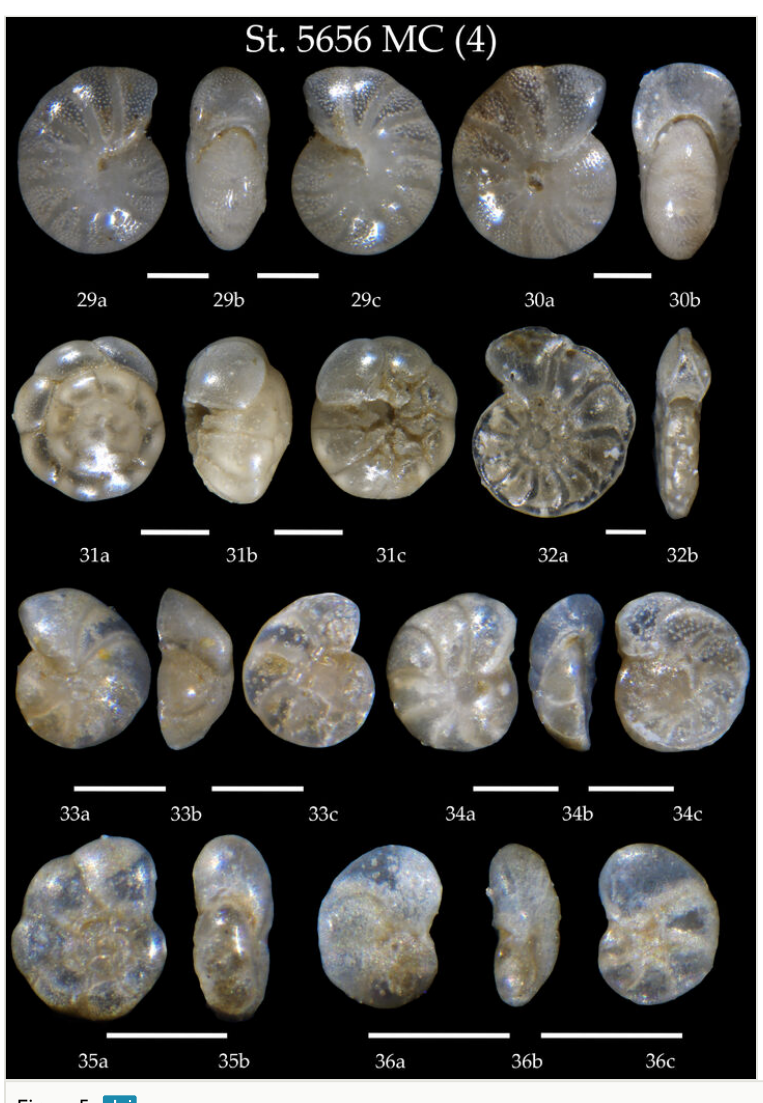
Figure 5. Station 5656 M С (continued). 29 Melonis barleeanus , a side view, b apertural view, c lateral view; 30 Melonis pompilioides , a side view, b apertural view; 31 Ammonia falsobeccarii , a spiral view, b apertural view, c umbilical view; 32 Hyalinea balthica , a side view, b apertural view; 33 Cibicides refulgens , a spiral view, b apertural view, c umbilical view; 34 Cibicides lobatulus , a spiral view, b apertural view, c umbilical view; 35 Epistomaroides polystomelloides , a side view, b apertural view; 36 Planulina ariminensis , a spiral view, b apertural view, c umbilical view. Scale 100